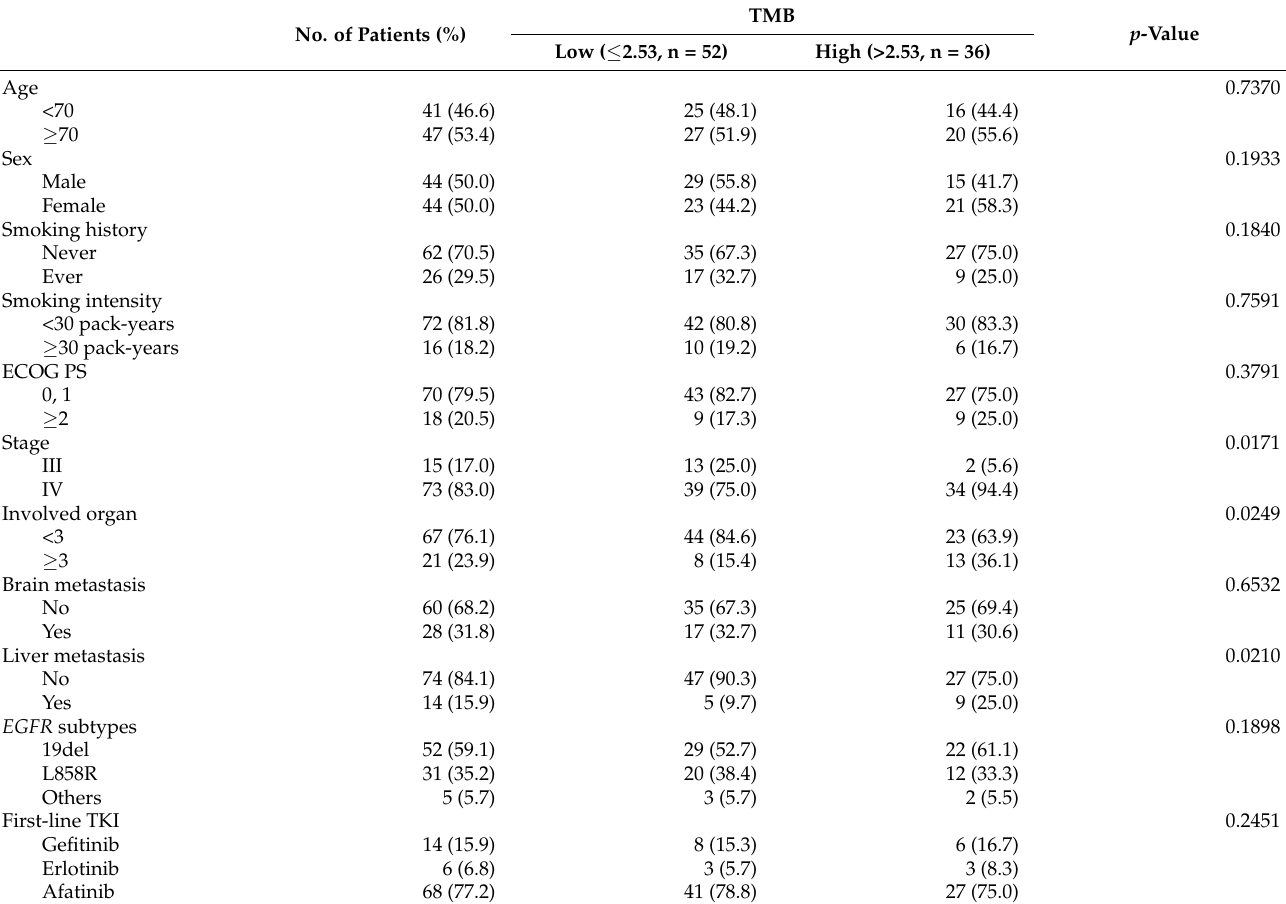
Table 1. Characteristics of the 88 study patients stratified by TMB